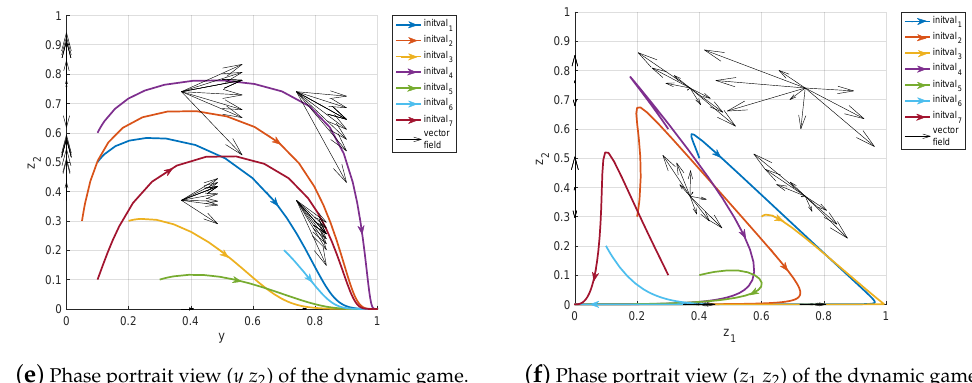
( f ) Phase portrait view ( z 1 z 2 ) of the dynamic game.